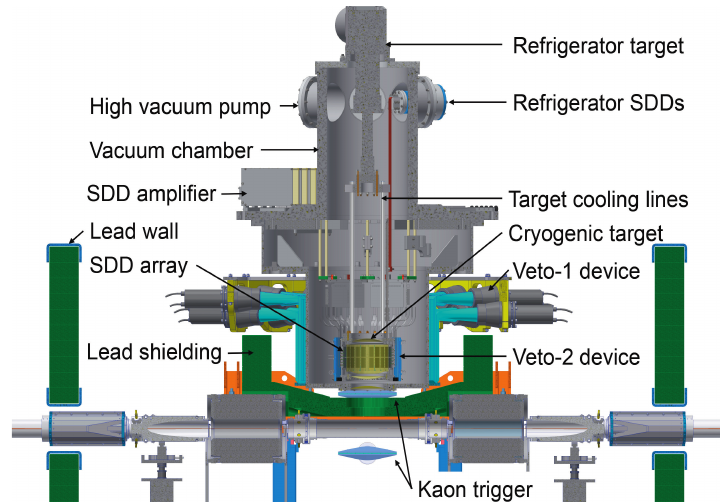
Figure 7: Schematic view of the SIDDHARTA-2 setup consisting mainly of the cryo- genic target cell, surrounded by the SDDs arrays, kaon trigger, the Veto-2 system within the vacuum chamber and the Veto-1 device placed outside the